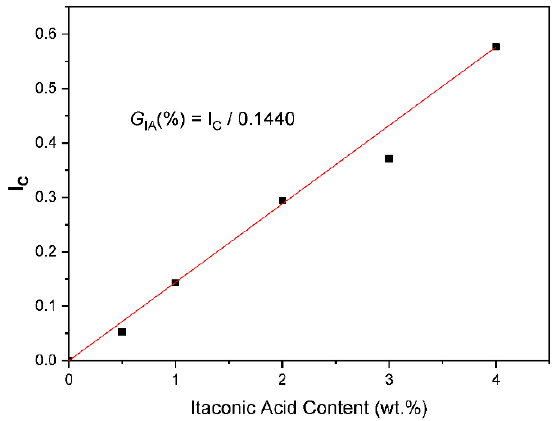
Figure 3. Calibration curve for estimating the percentage of grafted IA onto SEBS. Solid squares correspond to experimental data, while the red line is the fit curve.